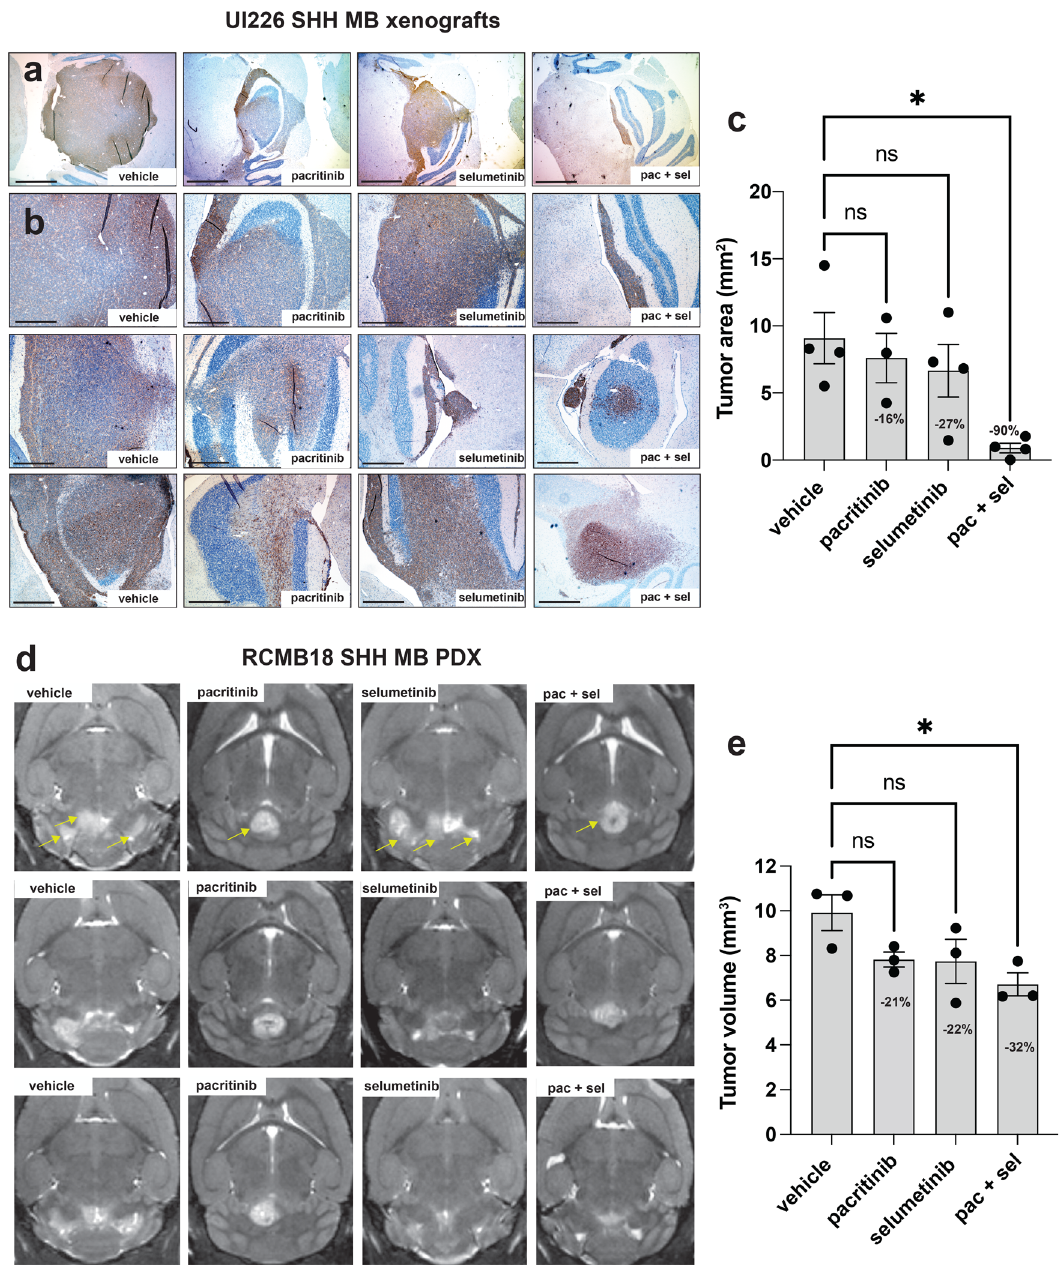
Fig. 7 MEK + JAK/STAT3 inhibition decreases tumor growth in 2 SHH MB in vivo xenograft models. Representative IHC images of STEM121 levels at low magni fi cation ( a ) and higher magni fi cation ( b ) from three independent tumors from each of the vehicle control, pacritinib, selumetinib,